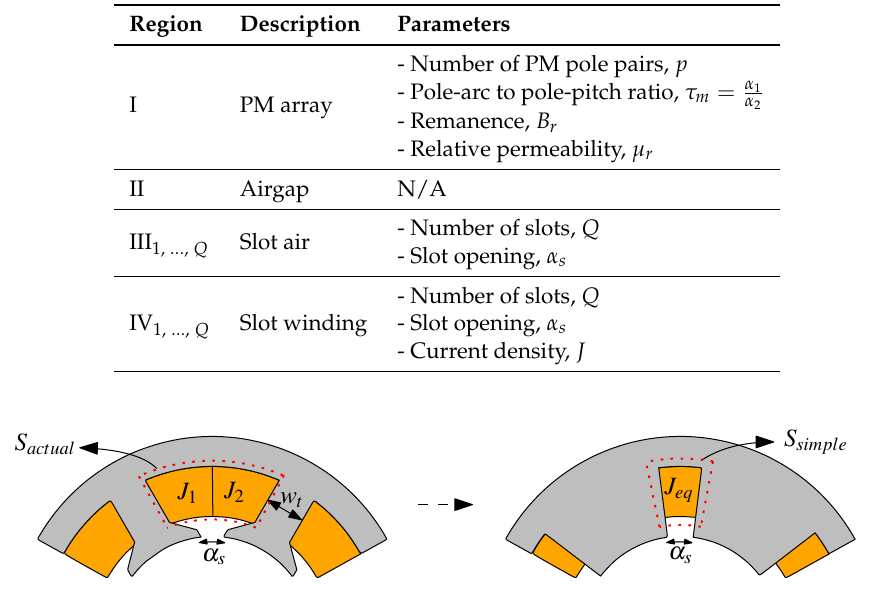
Table 1. Modeled regions in the motor, based on Figure 4.